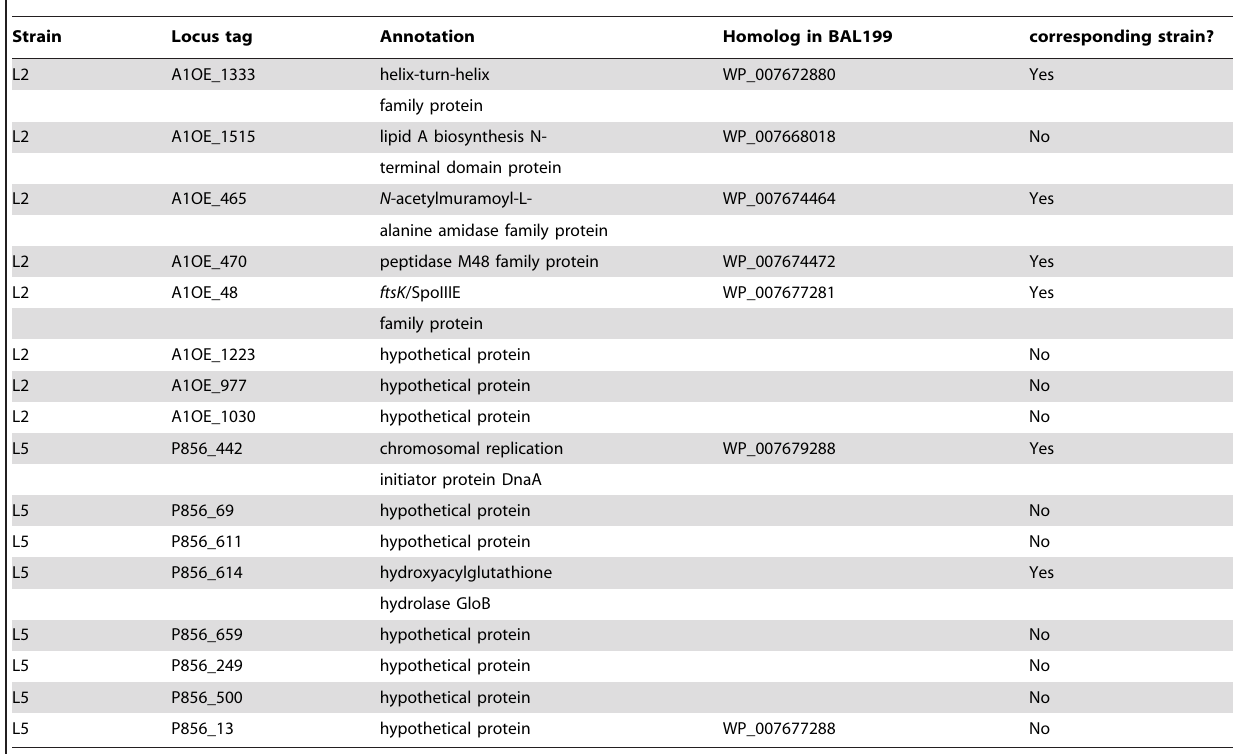
Table 3. Orphan genesa in Ca. E. faulkneri strains L2 and L5.